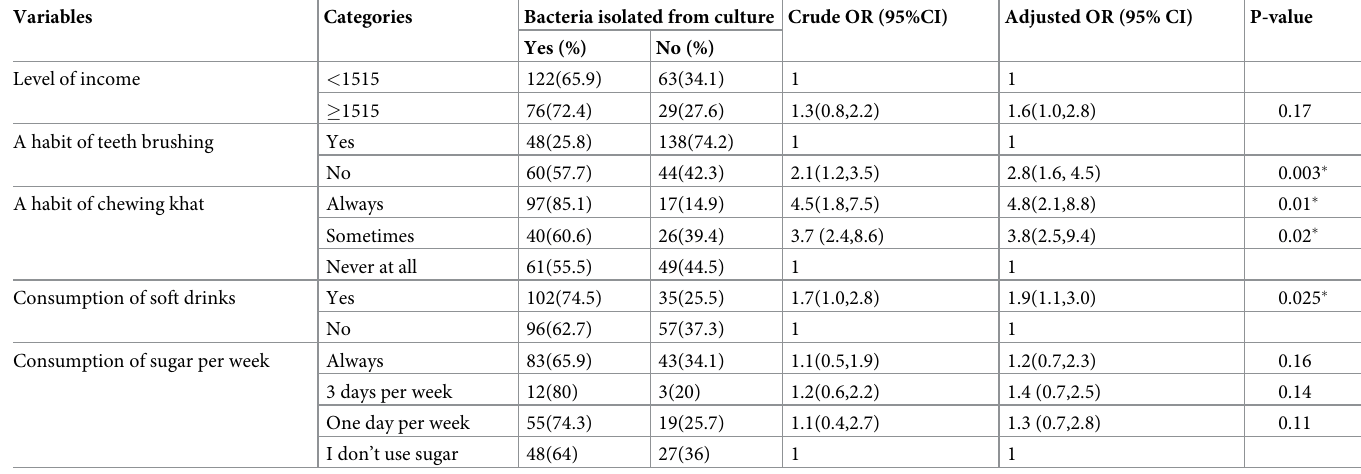
Table 3. Factors associated with bacterial isolation among dental caries patients attended Hiwot Fana comprehensive specialized university hospital dental clinic (N = 290), Eastern Ethiopia from April to June